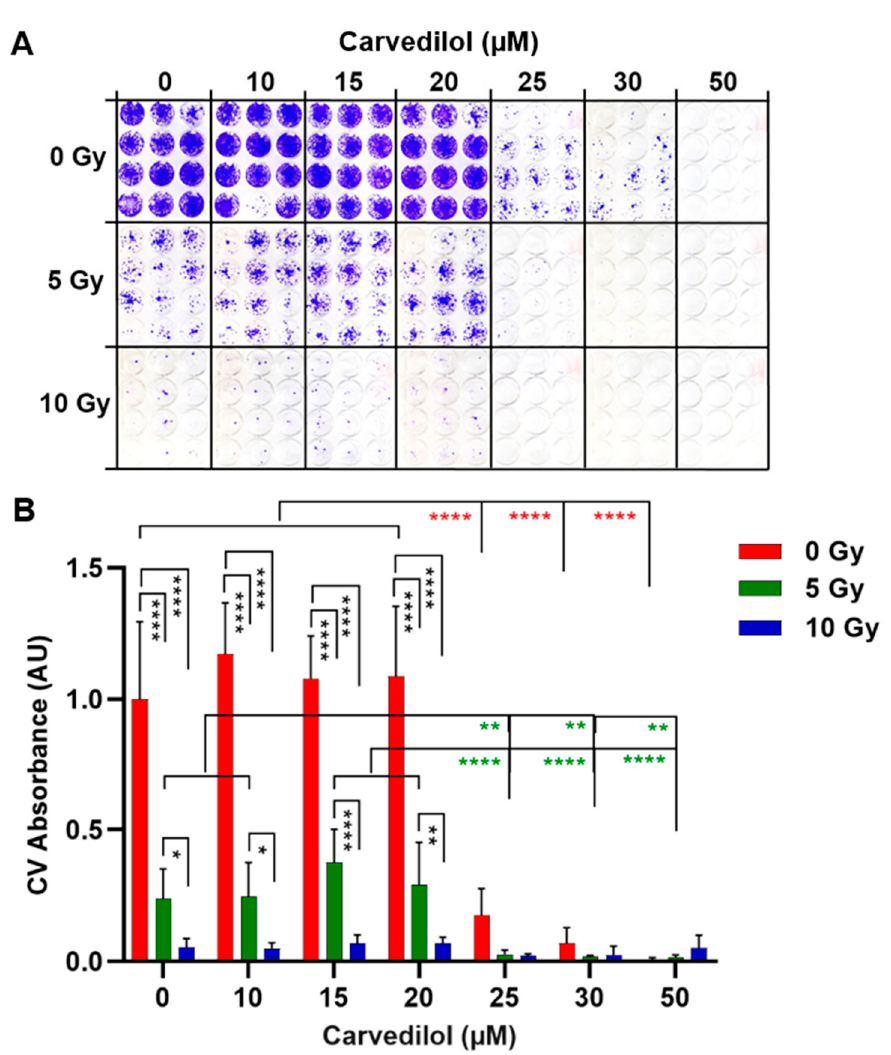
Figure 8. Long-term survival and repopulation after co-treatment of 3D tumor spheroids with carvedilol and radiation. Spheroids were generated from the UPMM3 cell line and treated with carvedilol and/or radiation at 5 or 10 Gy. After four days of incubation, individual spheroids were transferred into flat-bottom wells to enable the out-growth of cells. Cells were cultured until control cells (0 µ M carvedilol, 0 Gy) were confluent. After 4 weeks, cell cultures were stained crystal violet (CV). ( A ) Representative images of CV-stained cell cultures ( n = 12) for each condition are shown. ( B ) Measurements of CV absorption ( n = 12 each condition). The CV absorption of the treated cells was normalized to the CV absorption of the control cells (0 µM Carvedilol, 0 Gy) and is given in arbitrary units (AU). Representative results of 3 independent results are shown. The means ± SD of n = 12 spheroids for each condition are shown. Statistical analysis was performed with two-way ANOVA and Tukey’s multiple comparisons test, and significance levels are indicated at * p < 0.05, ** p < 0.01, **** p < 0.0001.